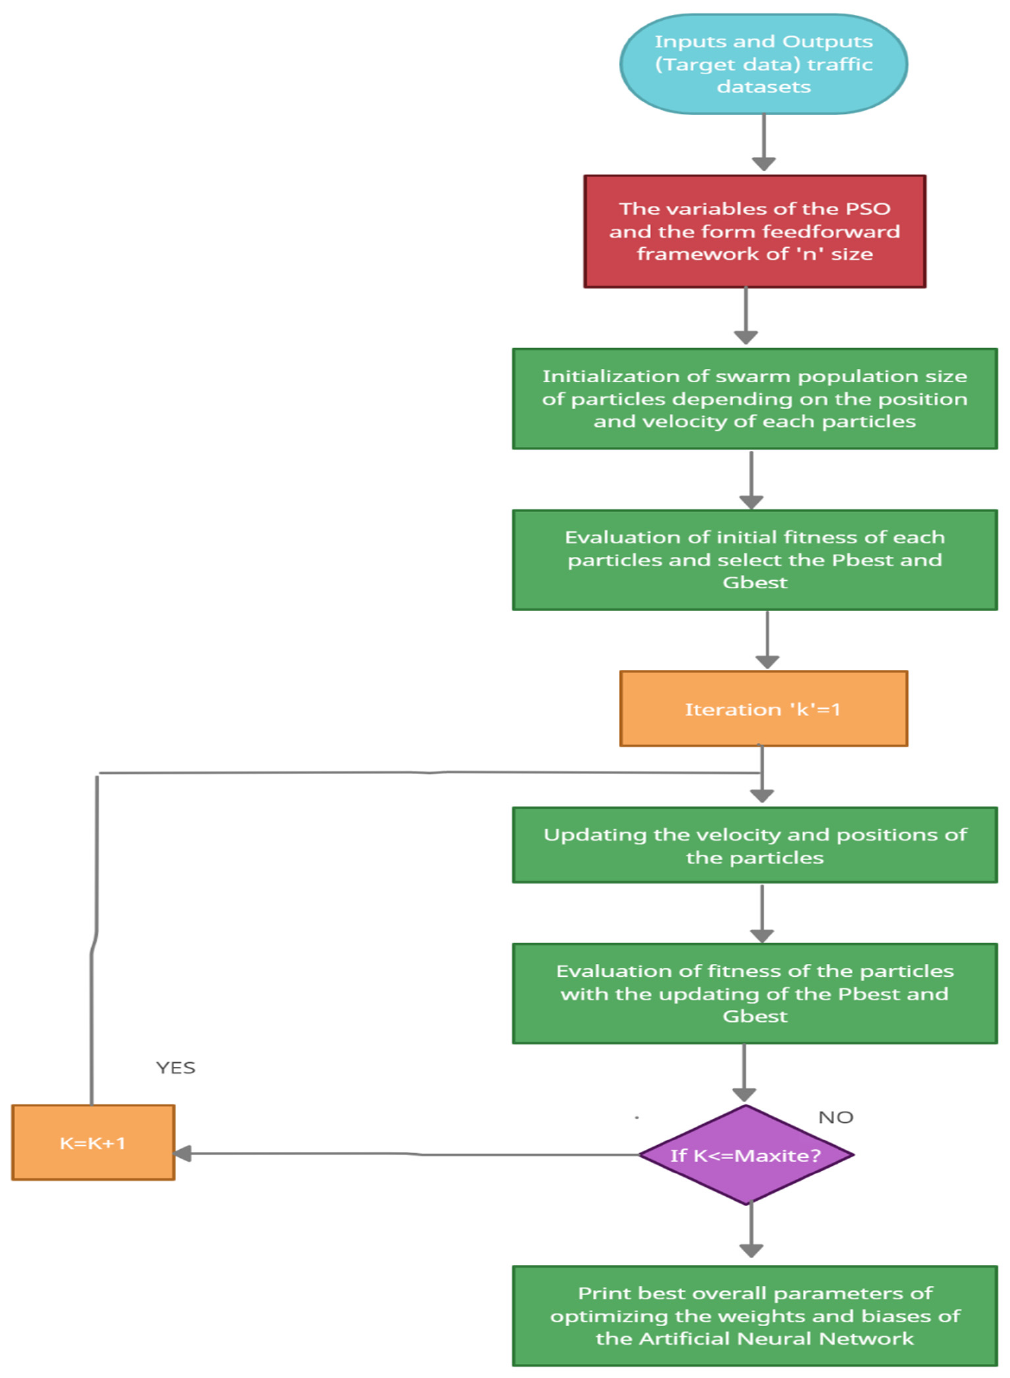
Figure 8. A framework of the ANN-PSO Model developed for the traffic flow prediction performance. A programming language has been inbuilt in the MATLAB environment, assuming that there is a three-layer artificial neural network architecture. The number of input and output variables considered for developing the artificial neural network-particle swarm optimization model is shown in Table 2. In this study, the number of neurons used varies between five (5) and ten (10), respectively. The ANN-PSO model has variables, which are dependent on particle swarm optimization or the artificial neural network. The PSO variables include the overall number of particles in the swarm population size (swarm size, N), acceleration factor associated with the particle velocity ( C 1 and C 2 ), the inertial